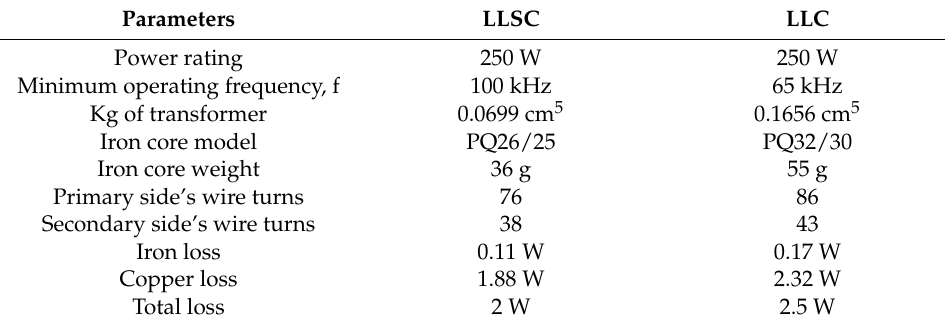
Table 2. Magnetic substance